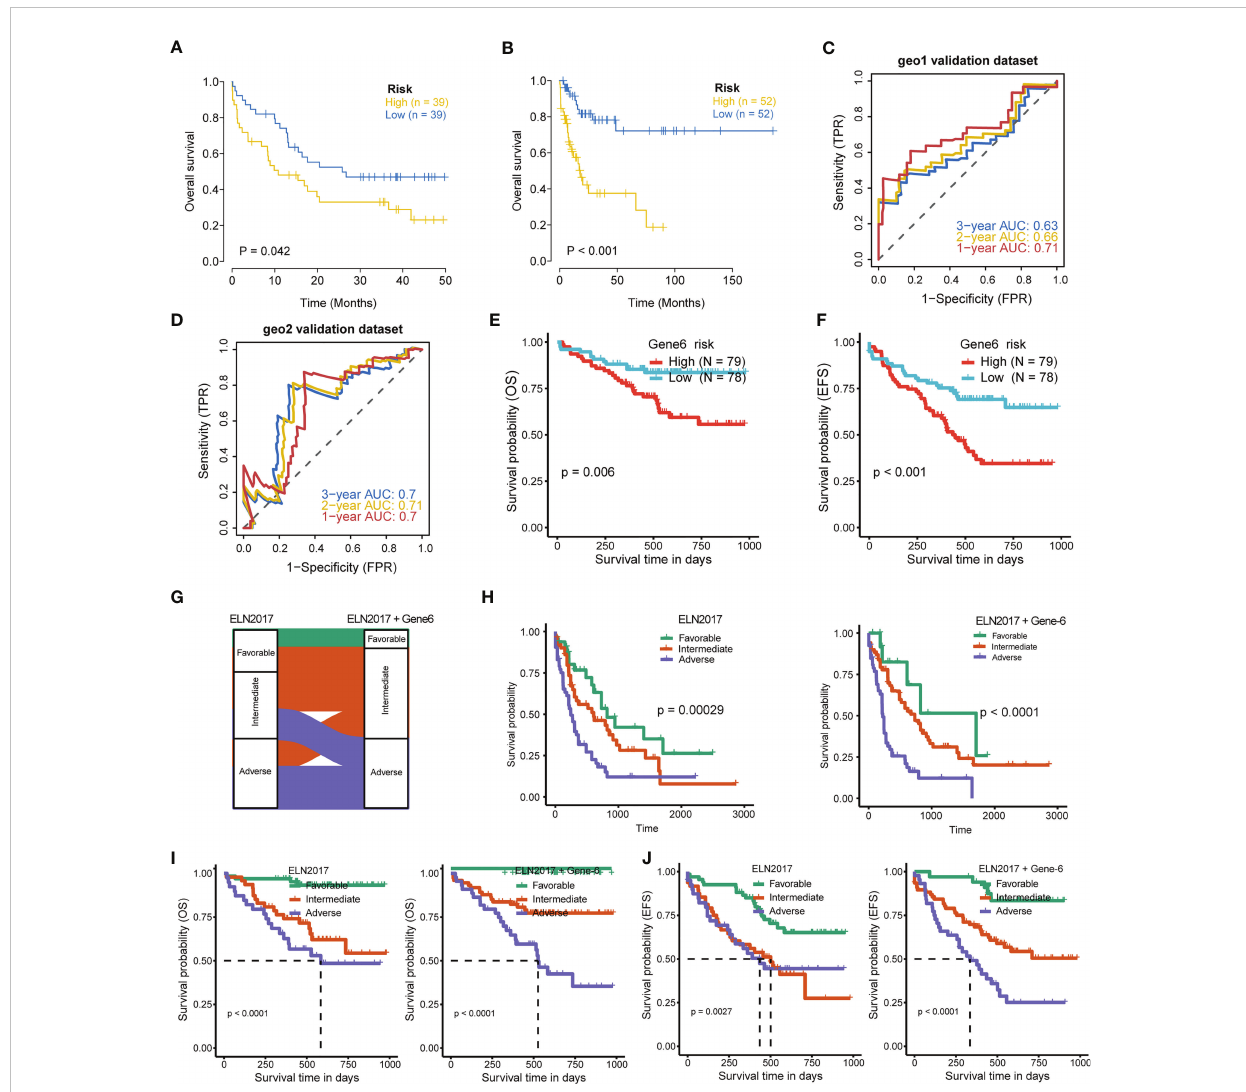
FIGURE 5 Validation of 6-gene prognostic signature. (A, B) Kaplan-Meier curves for OS of high- and low-risk groups in validation datasets (GSE12417 dataset, geo1; GSE71014 dataset, geo2). (C, D) ROC curves of the risk score in geo1 and geo2 validation gene set (AUC values > 0.6 at 1, 2, and 3 years in the geo1 validation dataset; AUC values > 0.7 at 1, 2, and 3 years in the geo2 validation dataset). (E, F) OS and EFS of high- and low-risk groups in RJAML cohort. (G) Improvement of the ELN2017 classi fi cation incorporating with Gene6 signature. (H) Comparison of OS segregation between different